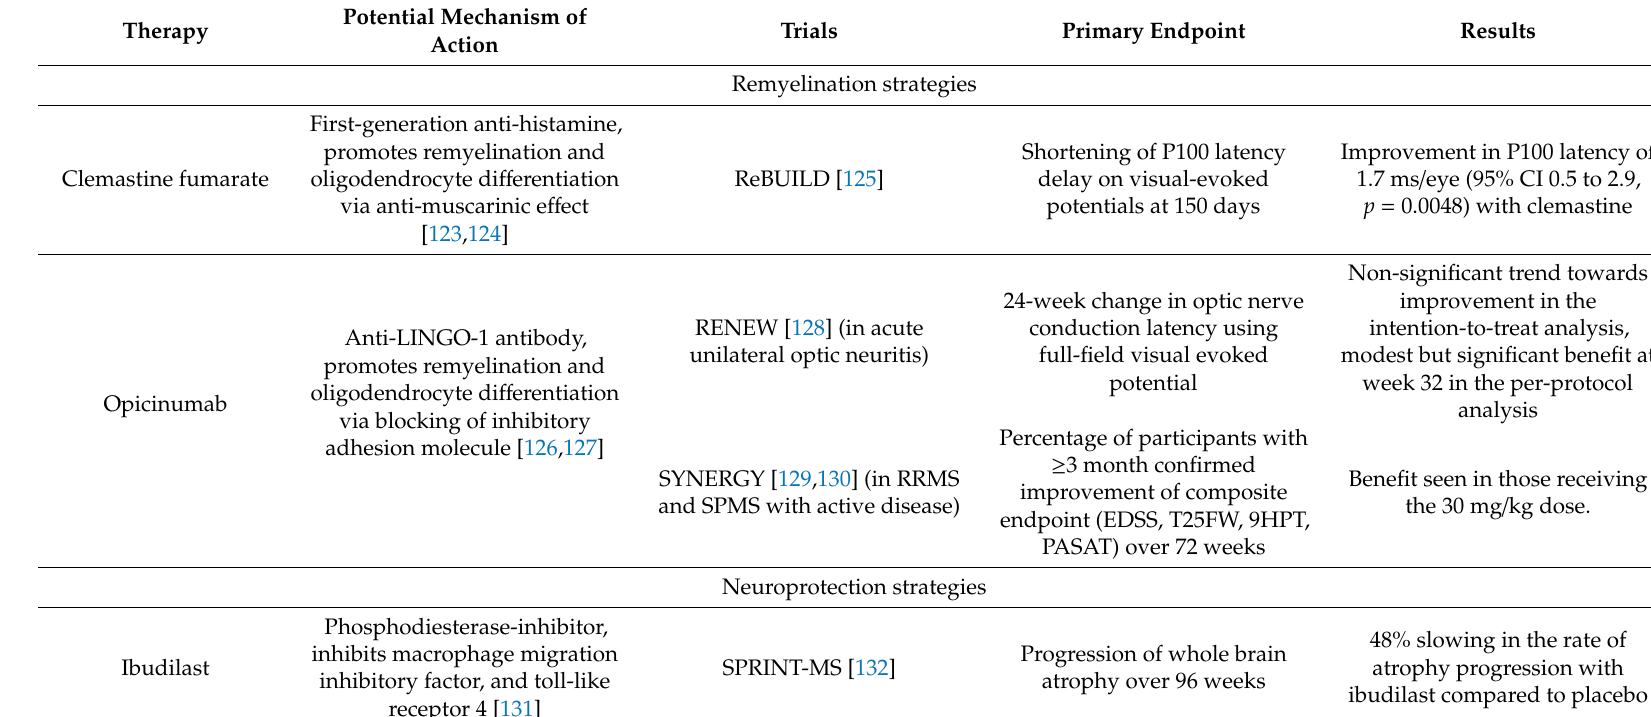
Table 1. Potential remyelinating and neuroprotective molecules studied in multiple